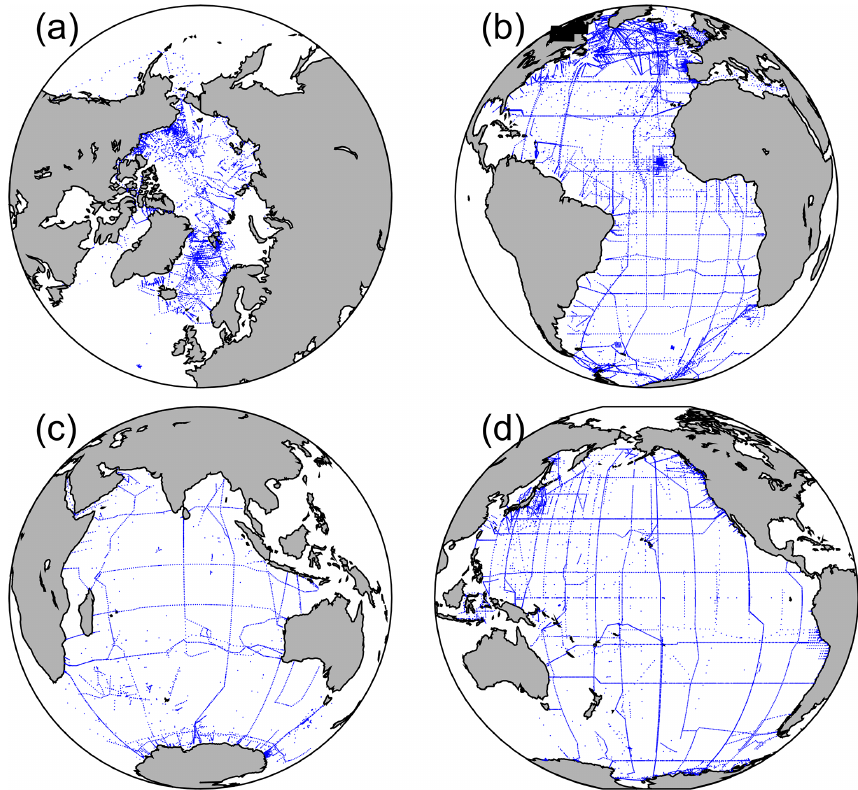
Figure 8. Locations of stations included in the (a) Arctic, (b) Atlantic, (c) Indian, and (d) Pacific ocean product files for the complete GLODAPv2.2021